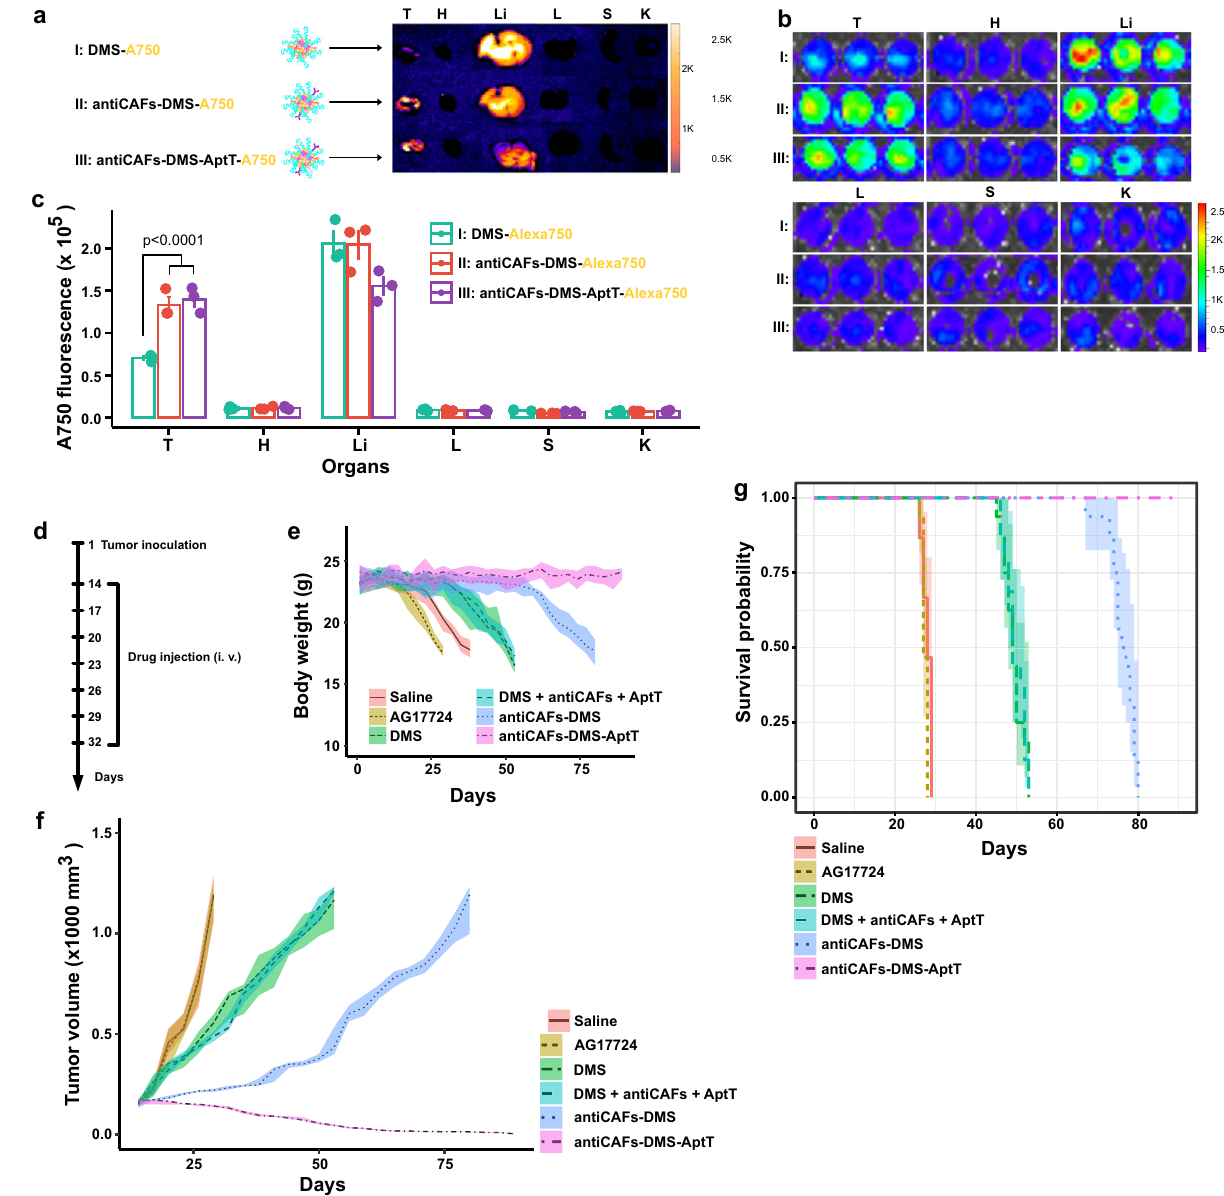
Fig.5|Biodistributionandtherapeuticeffects.a Representativeexvivoimaging of tumors and organs (T tumor, H heart, Li liver, L lung, S spleen, K kidney) from mice intravenously injected with Alexa750-labeled DMS, antiCAFs-DMS, and antiCAFs-DMS-AptT. b Representative imaging of homogenates prepared from tumors or organs (T tumor, H heart, Li liver, L lung, S spleen, K kidney) from mice intravenously injected with Alexa750-labeled DMS, antiCAFs-DMS, and antiCAFs- DMS-AptT. c Quantitative Alexa750 fl uorescent intensity analysis of